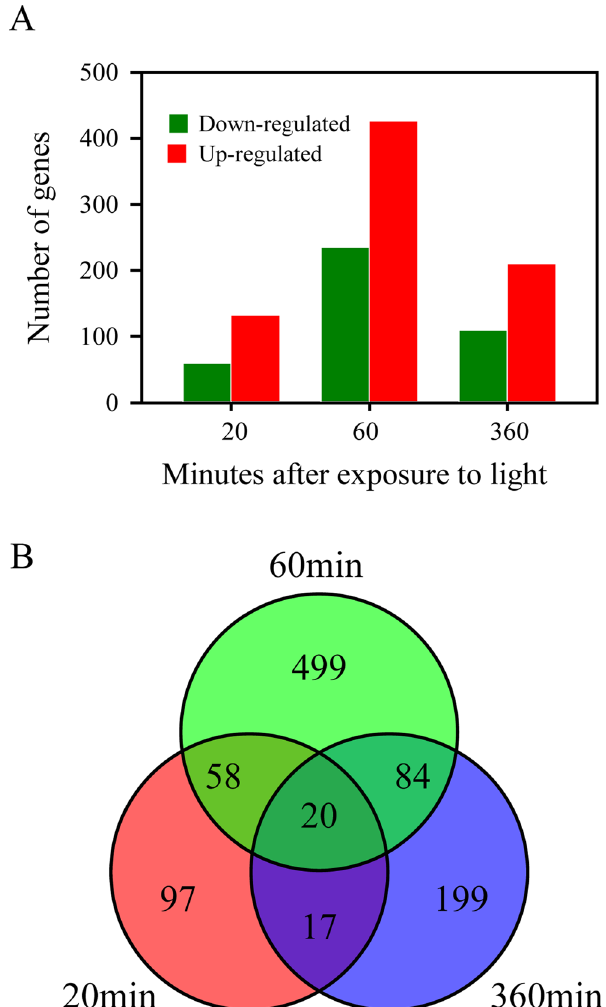
Figure 2. Comparative analysis of transcriptomic changes in rice mesocotyl in response to light at three time-points. ( A ) Number of up-regulated and down-regulated DEGs after light treatment. ( B ) Venn diagram constructed using the DEGs with changes of more than four folds and the FDR values less than 0.05 for at least one time